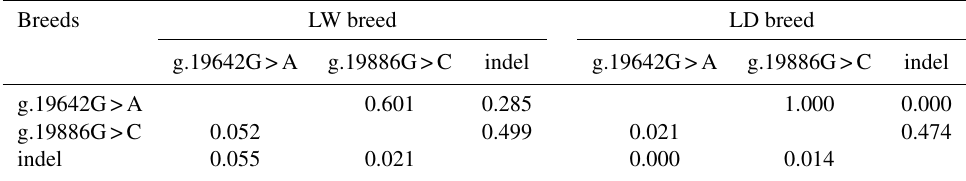
Table 4. D (cid:48) and r 2 values of pairwise linkage disequilibrium of the SPEF2 gene in pig breeds. Breeds LW breed LD